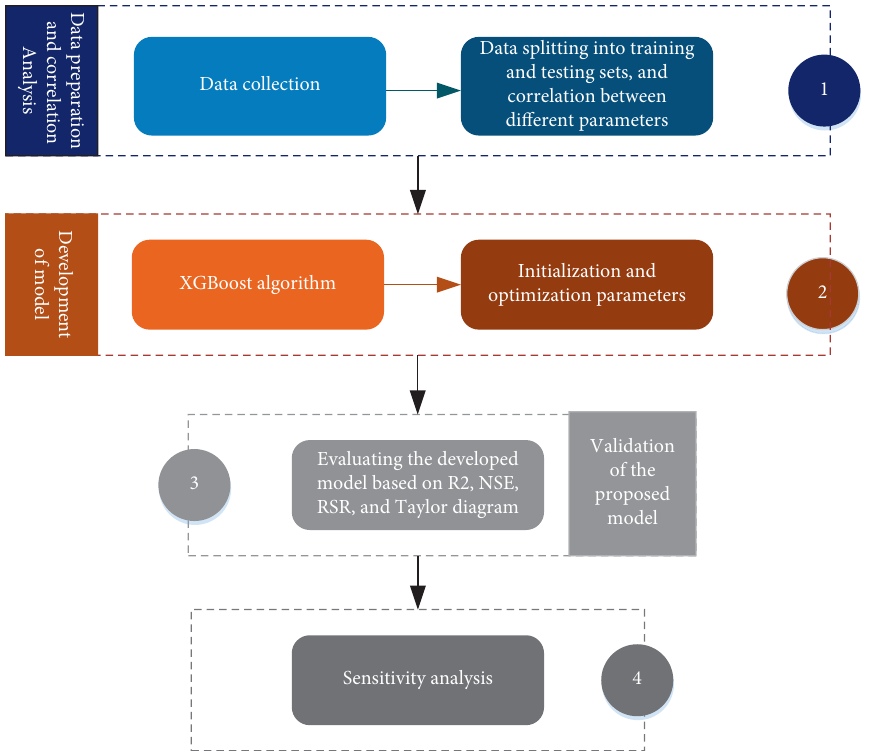
Figure 2: Flowchart illustrates the proposed methodology for present